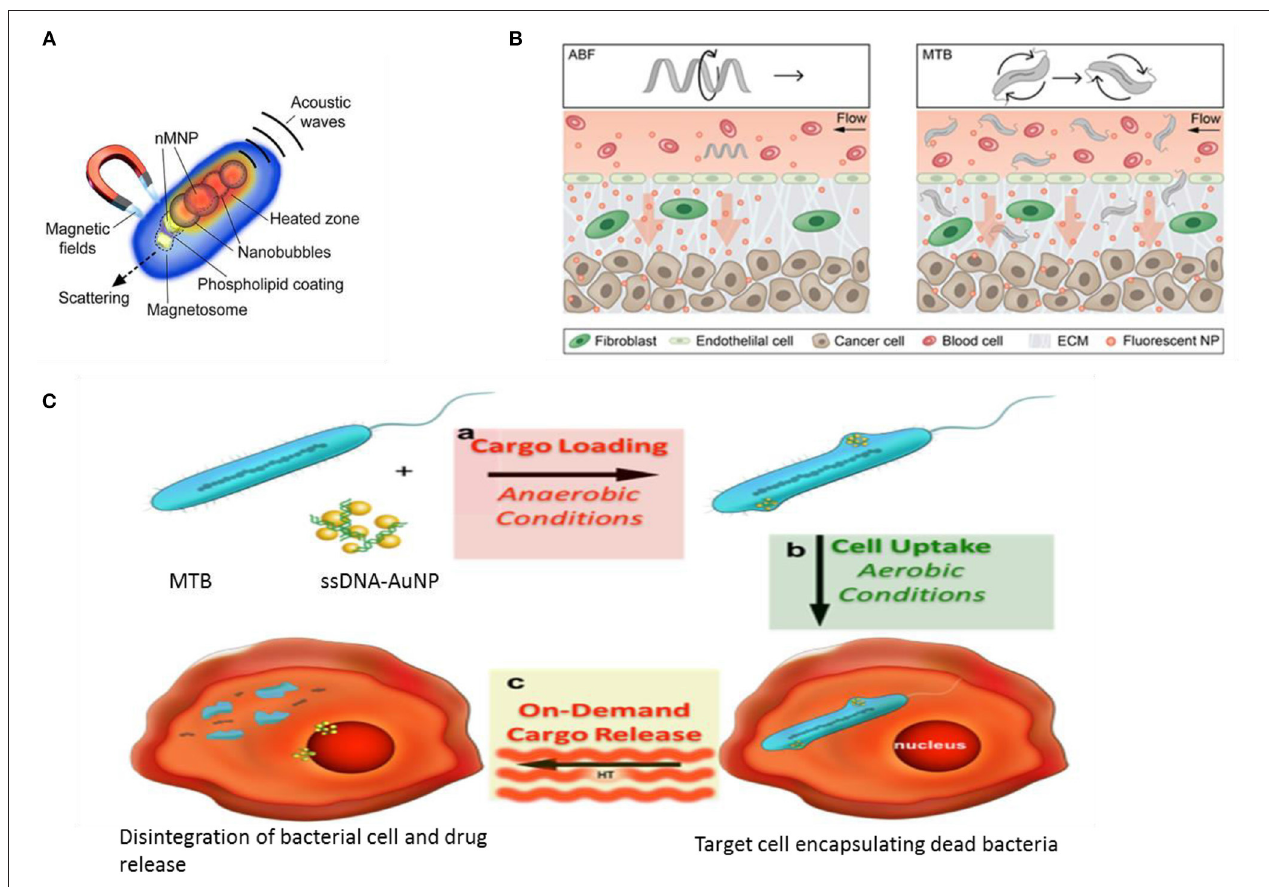
FIGURE 2 | Magnetotactic bacteria (MTB) and drug delivery applications. (A) MTB as a multimodal photoacoustic, photothermal, and photomechanical contrast agent for single cell diagnostic and therapy (Nima et al., 2019). (B) Conceptual diagram depicting a single microrobot, the Artificial Bacterial Flagellum ABF, enhancing mass transport of NPs at the vessel -tissue interface (left), and swarms of MTB generating convective flow to improve mass transport (right). ECM ExtraCellularMatrix (Schuerle et al., 2019). (C) Drug delivery using physiological limitation of MTB under hyperthermia radiation (Alsaiari et al.,